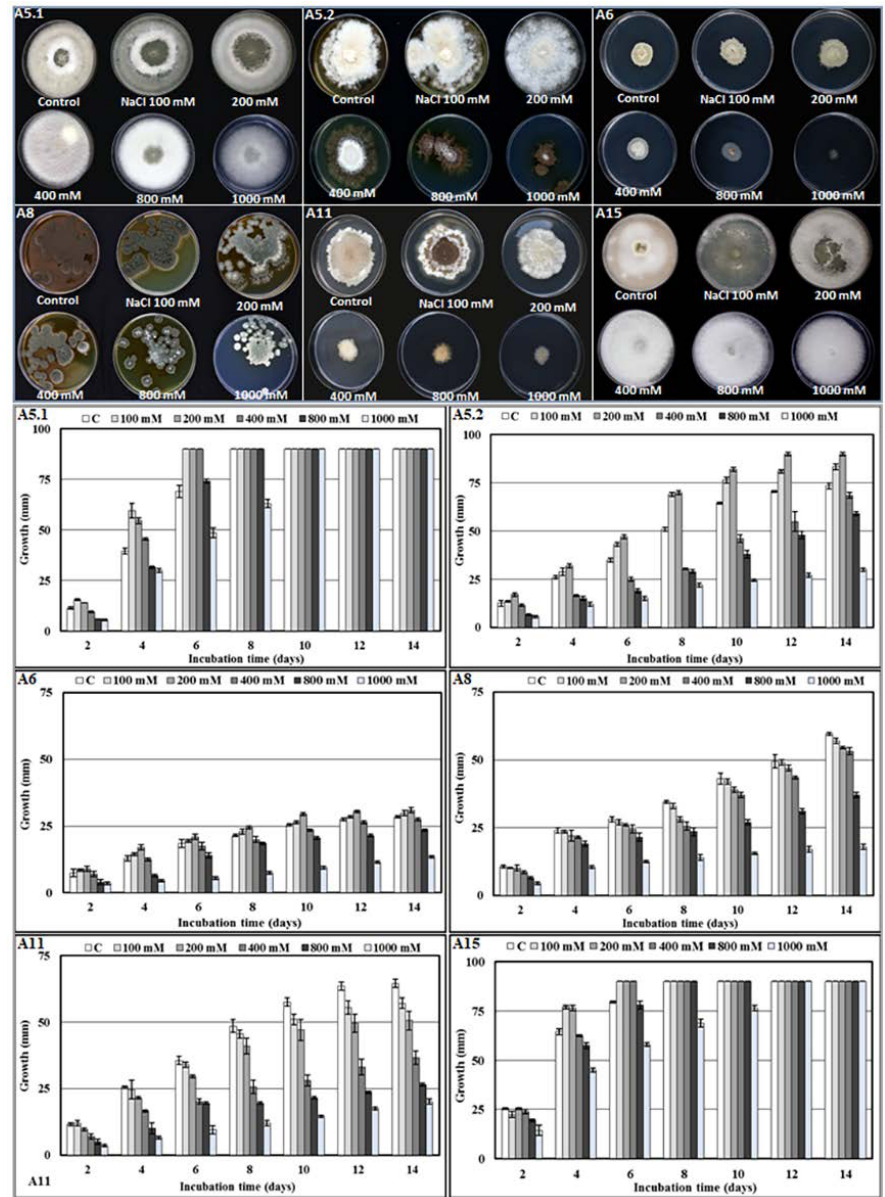
Figure 3. Morphology and growth rate of the six isolated strains ( A5.1 , A5.2 , A6 , A8 , A11 , and A15 ) incubated at different NaCl concentrations (100, 200, 400, 800, and 1000 mm) during 14 days at 27 ◦ C. ( A5.1 : Byssochlamys spectabilis ; A5.2 : Chaetomium globosum ; A6 : Cephalotheca foveolata ; A8 : Penicillium melinii ; A11 : Alternaria tenuissima ; and A15 : Nigrospora chinensis